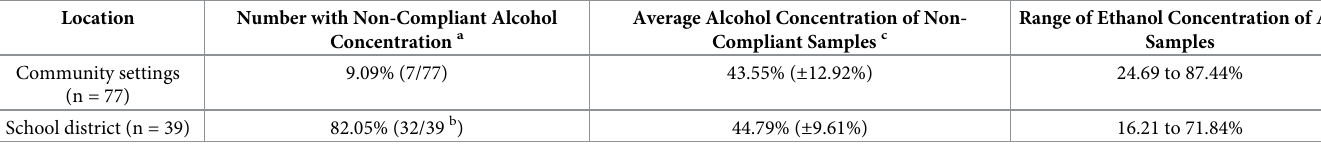
Table 3. Results of alcohol concentration analysis of ABHS samples from bulk refillable